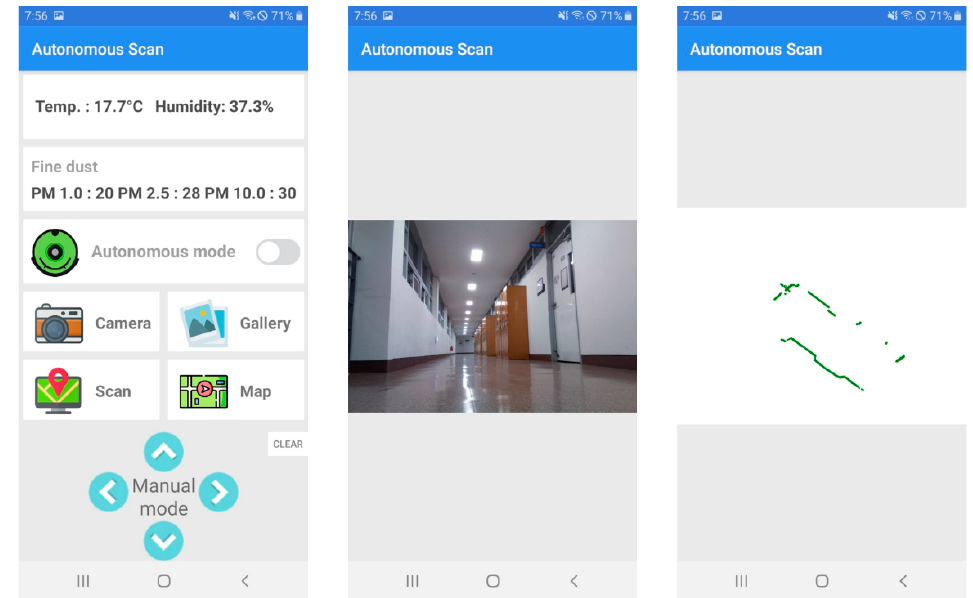
Figure 21. Environmental data result ( left ), captured image ( middle ), and scanned result ( right ) at position (marked 7 in Figure 15) from which first autonomous scanning experiment was performed.